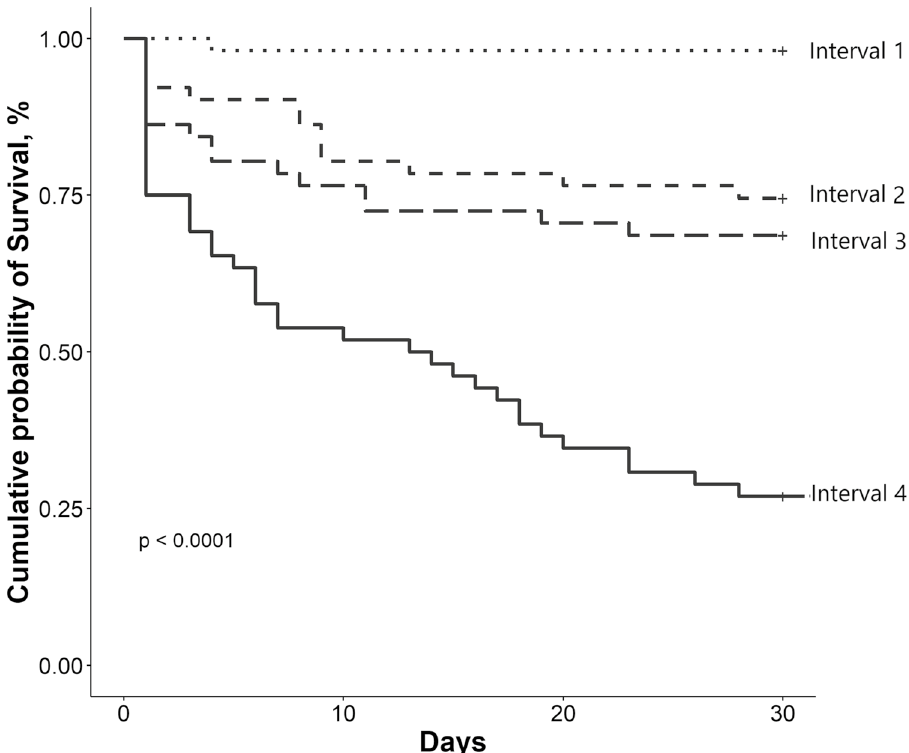
Figure 3. Kaplan–Meier survival curve for HBPc-48 h in four